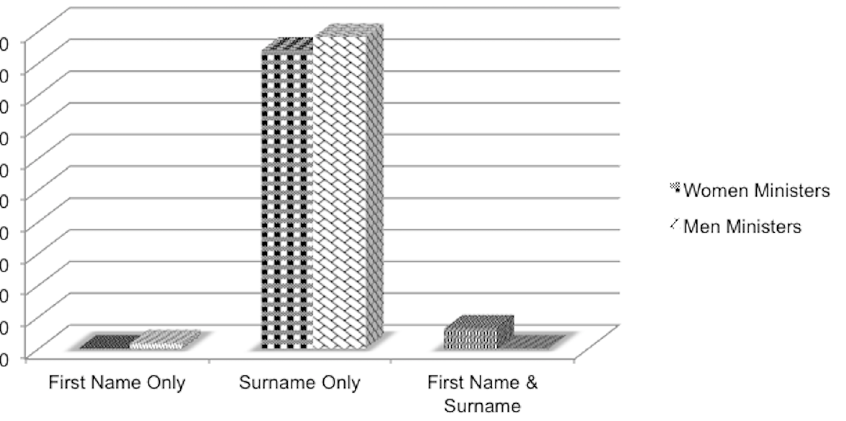
Figure 1. Trends in percentage of the use of first name, surname, and full names for women and men ministers.